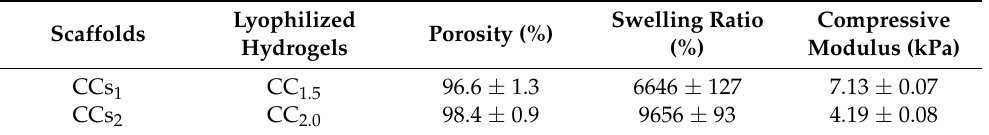
Table 2. Basic properties of the CC scaffolds with different formulae